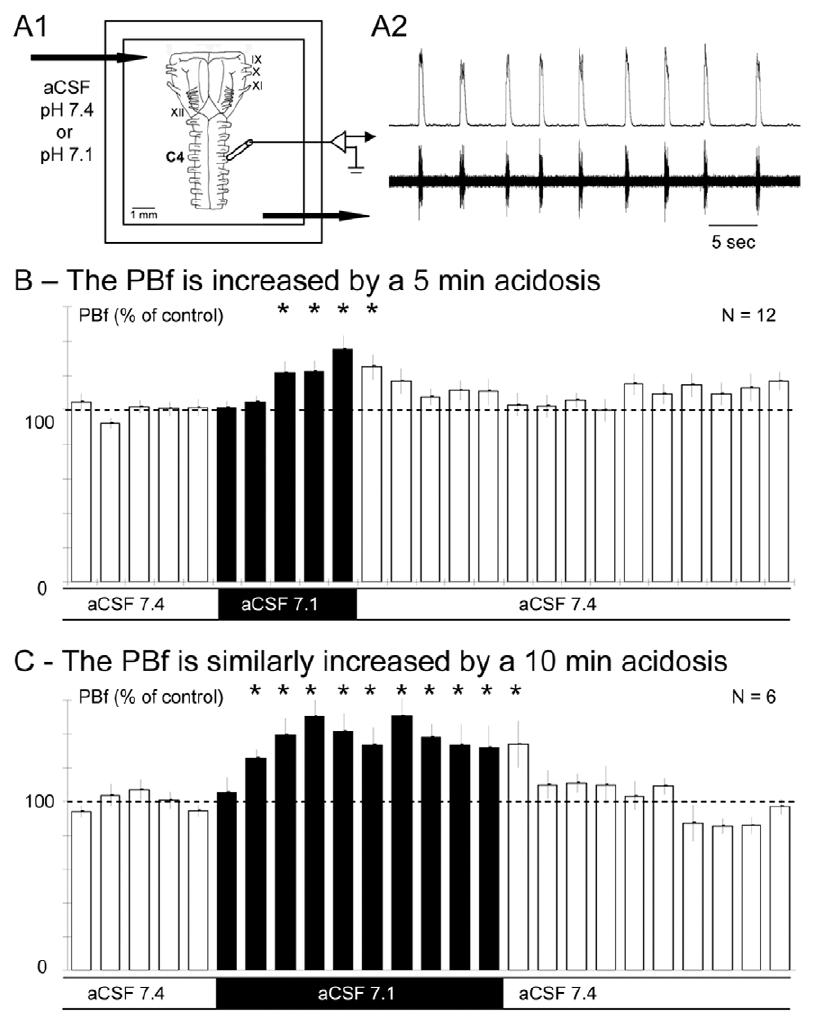
Figure 1. Acidosis increases the phrenic burst frequency of en bloc medullary preparations. A – Schematic presentation of the en bloc preparation of neonatal mice (A1) and example of raw and integrated phrenic bursts (bottom and top traces, respectively) produced by the isolated respiratory rhythm generator (RRG) on the C4 ventral roots of en bloc preparations (A2). B – Columns of the histogram show the mean (and SEM) phrenic burst frequency (PBf; expressed as % of the control PBf) measured every min (one column =1 min) in 12 en bloc preparations when the control aCSF(7.4) (white columns) superfusing the preparations was replaced by aCSF(7.1) for 5 min (black columns). Note that acidosis significantly increased the PBf (asterisks indicate a p , 0.05 statistical difference). C- As in B but aCSF(7.1) application for 10 min to 6 other preparations. Note that the PBf reached a plateau from the 5 th to the 10 th min of aCSF(7.1) application.